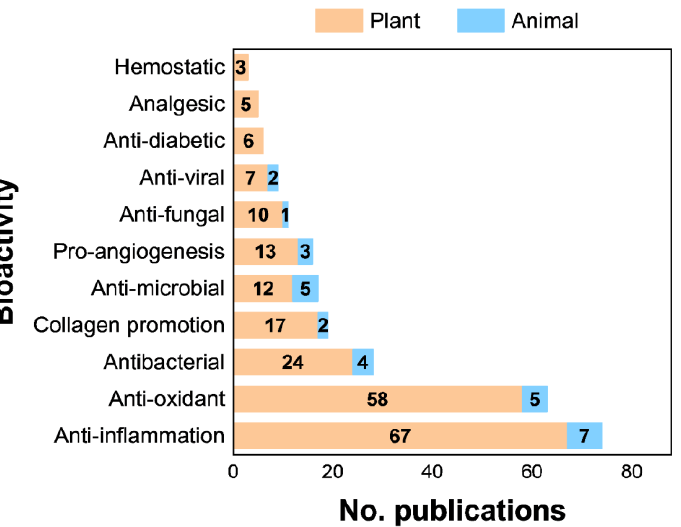
Figure 2. Summary of collected literature based on bioactivities of natural compounds used in wound